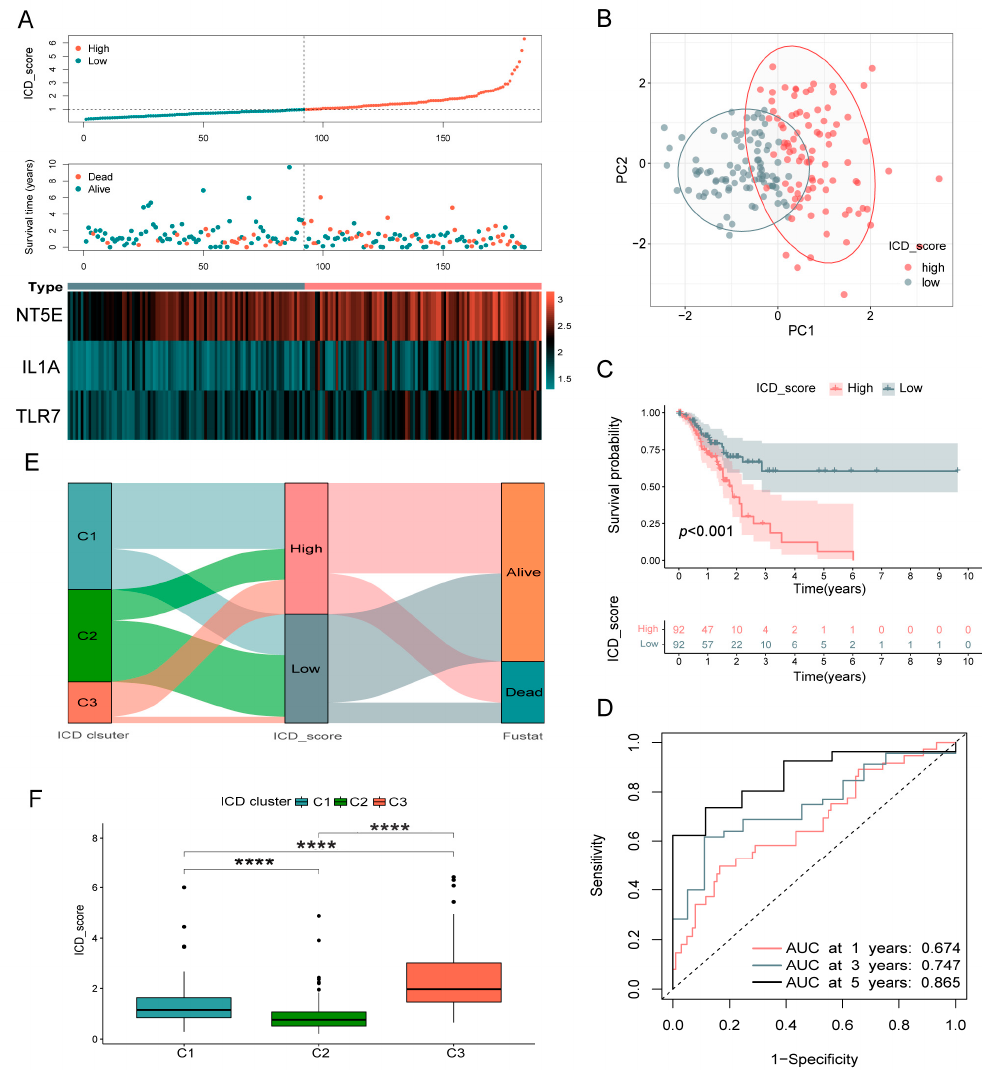
Figure 5. Validation of the ICD_score signature. ( A ) Risk score distribution, survival status of each patient, and heatmaps of prognostic three gene signature in TCGA database. ( B ) Principal component analysis based on ICD_score signature genes to distinguish low and high ICD_score subgroups in TCGA cohort. ( C ) Kaplan–Meier analysis of the OS between the two groups. ( D ) ROC curves to predict the sensitivity and specificity of 1 ‐ , 3 ‐ , and 5 ‐ year survival according to the ICD_score. ( E ) Alluvial diagram of subtype distributions in groups with different ICD_scores and survival outcomes. ( F ) Differences of ICD_score among ICD ‐ related subtypes. ROC, receiver operating charac ‐ teristic. **** p < 0.0001.